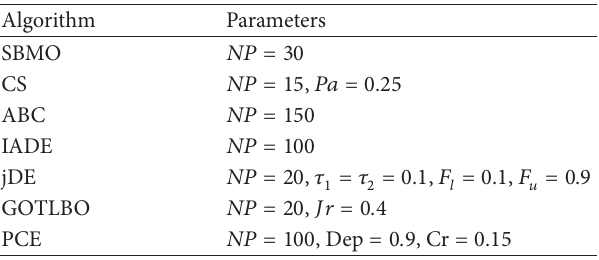
Table 8: Parameter settings of seven EAs.